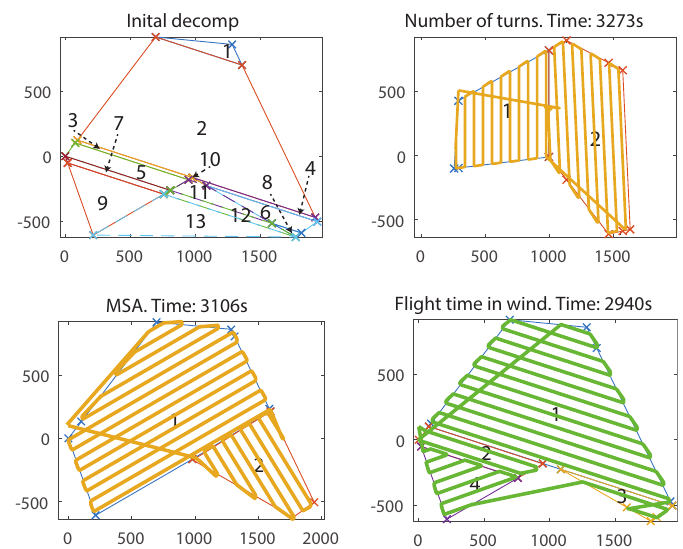
Figure 21. ( Top Left ) Initial decomposition of the example survey field in from Figure 19 at the best polygon rotation angle; ( Top Right ) decomposition and path generated from NT cost function. ( Bottom Left ) MSA cost function; ( Bottom Right ) fastest survey path, FTIW cost function